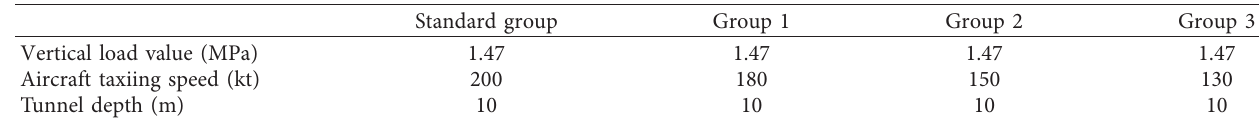
Figure 9: Distribution of soil hardening points around the tunnel. (a) Before the action of aircraft taxiing load. (b) After the action of aircraft taxiing load. Table 7: Calculation